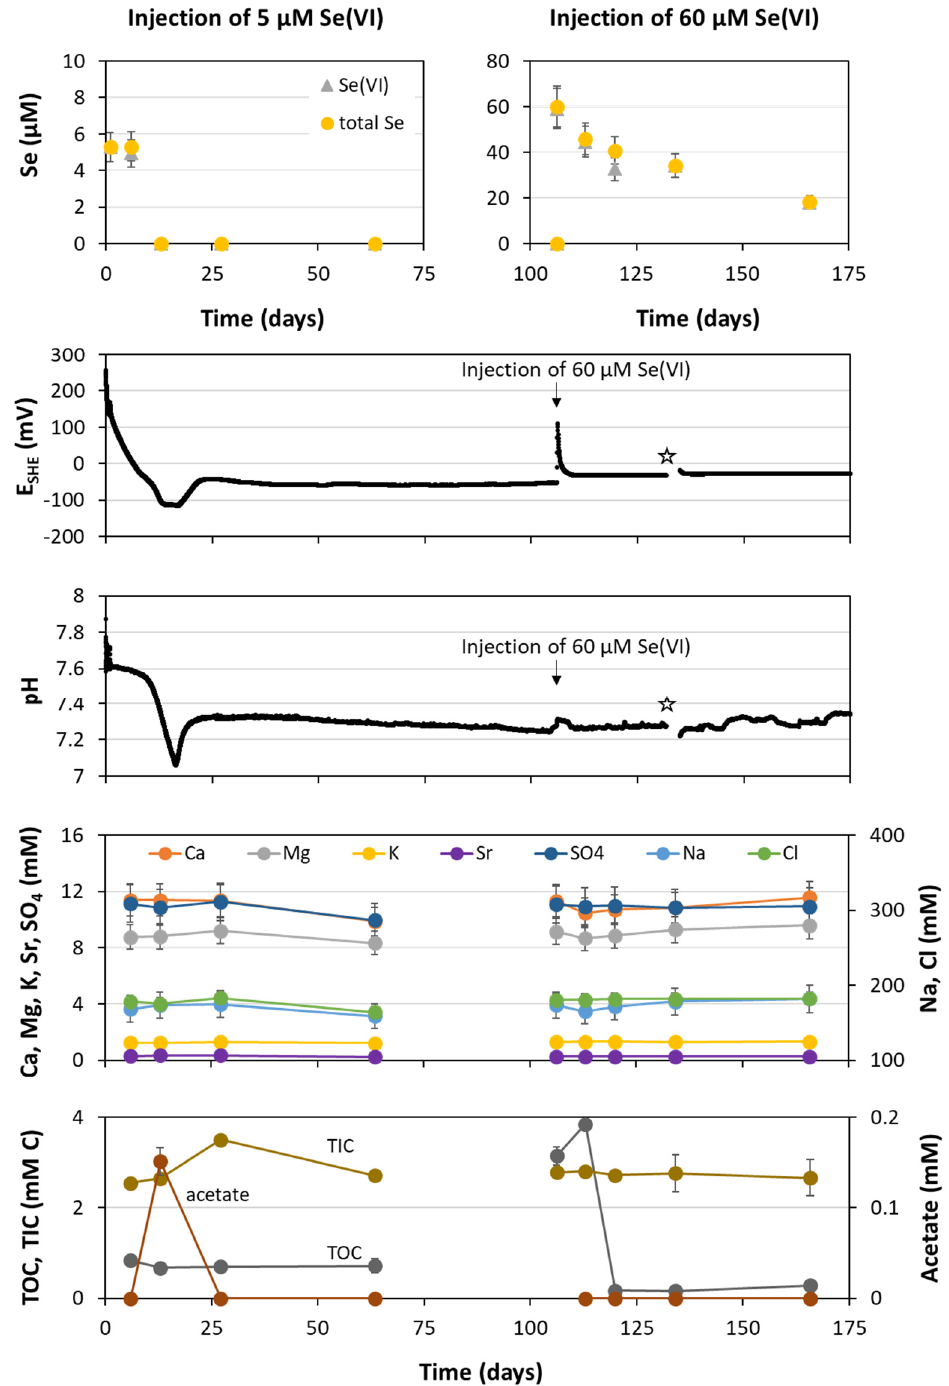
Figure 8. Evolution of the concentrations of Se(VI) (selenate) and total Se, the main components of the borehole pore water, organic and inorganic C, and pH and Eh as a function of time for both in situ injection tests, as shown at the top. The X -axis shows the entire experimental time frame, encompassing both injection tests with Se(VI). The experimental Se data were split in two graphs, one for each injection test, in order to visualize the ~12 times higher initial Se(VI) concentration of the second injection test. The error bars represent the measurement uncertainty (95% confidence). The combined uncertainty on the pH and Eh is 0.06 pH units and 32 mV, respectively (95% confidence interval), taking into account the measurement uncertainty observed immediately after calibration and the bias observed after ~1 year [37]. The star at ~132 days indicates an electrical power failure, resulting in a temporary lack of water circulation and online analysis.